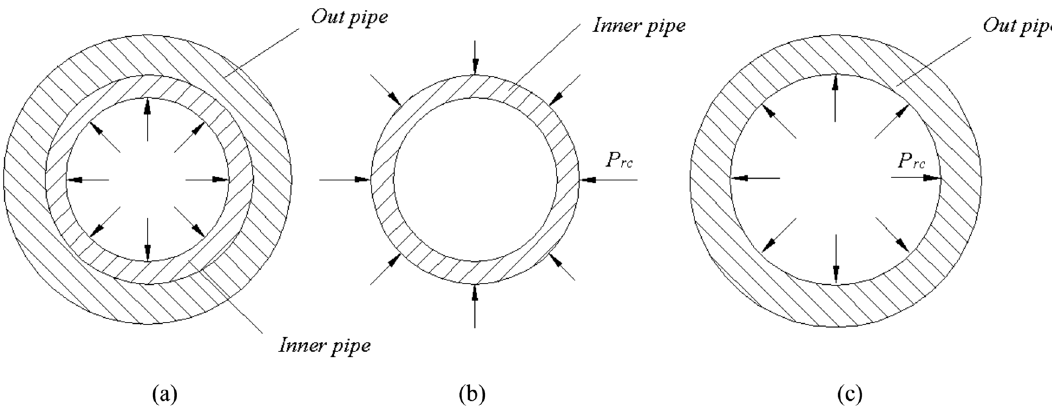
Fig. 4 Stress state of composite pipes when radial rotary pressure was unloaded